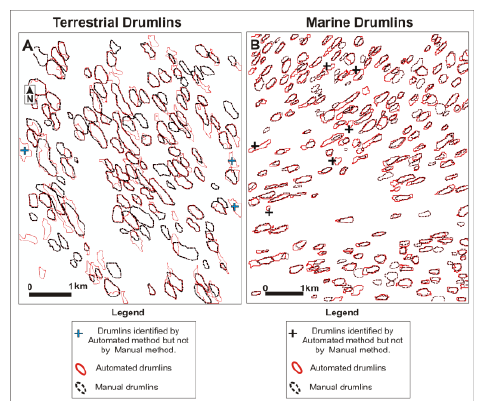
Figure 9. Visual comparison between automatically and manually extracted drumlins, both in A. the terrestrial test environment (see Saha et al. 2011) and B. the submarine test environment.